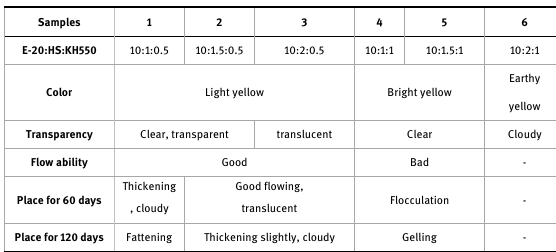
Table 3: Initial state and stability of the modified